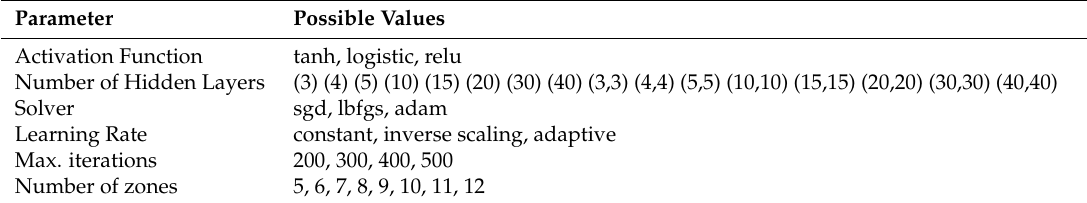
Table 2. Investigated parameter values.